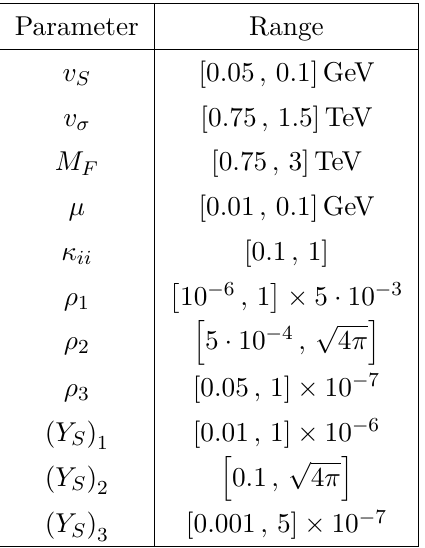
Table 2 . Ranges for the parameters that are randomly taken in our numerical